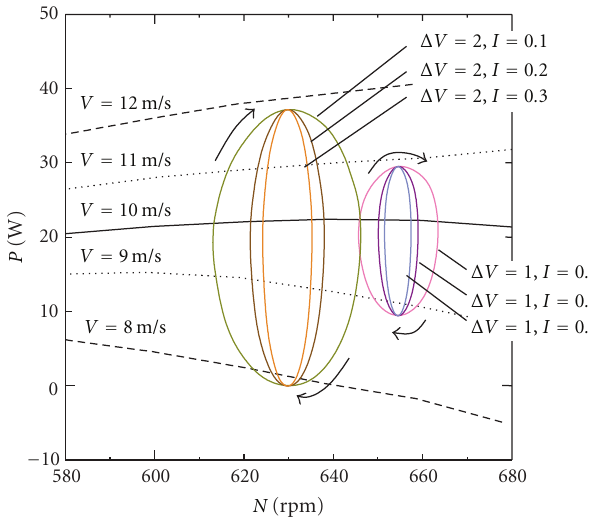
Figure 13: Loci of simulated mechanical power of the wind turbine in the case T = 4s. (Note: power curves of the wind turbine measured at five wind speeds from 8–12 m/s are also